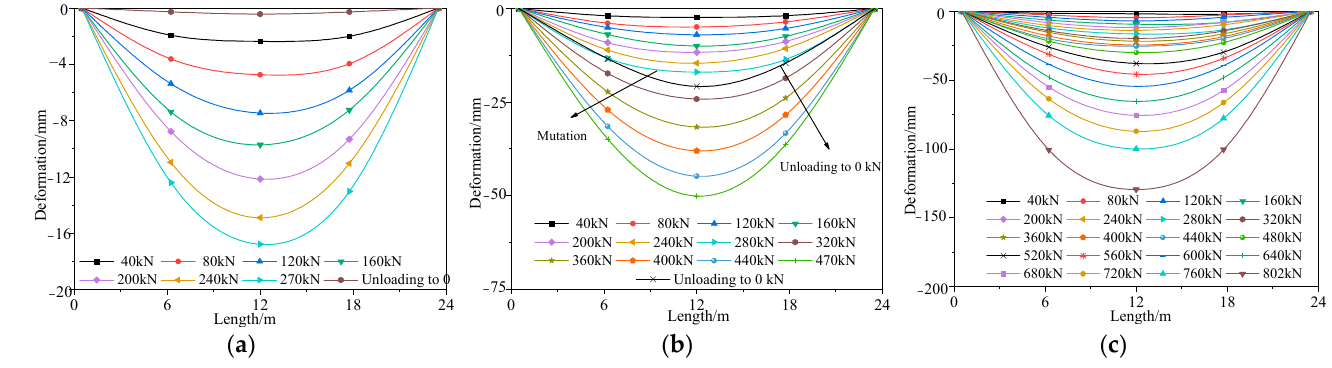
Figure 19. Deformation curve of the bottom plate of the repaired #3-2 girder strengthened by steel plates. ( a ) Elastic stage; ( b ) Working stage with cracks; ( c ) Failure stage.